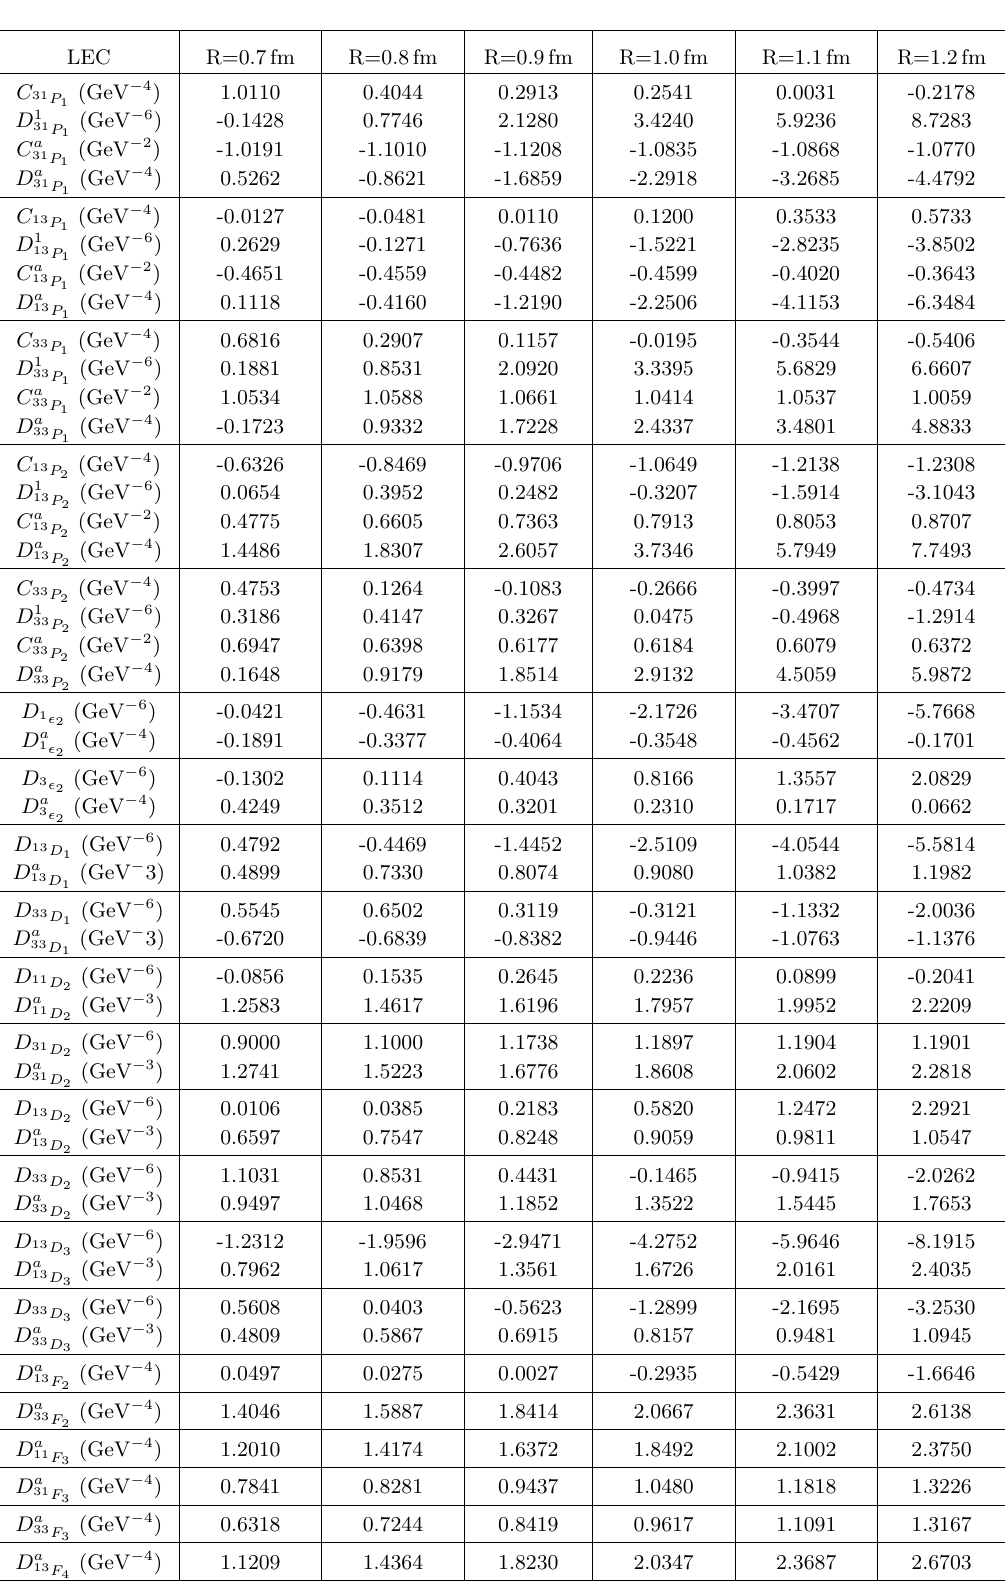
Table 6 . LECs at N 3 LO for di(cid:11)erent cuto(cid:11)s. The superscript a indicates parameters that are related to the annihilation part. Note that all parameters are in units of 10 4